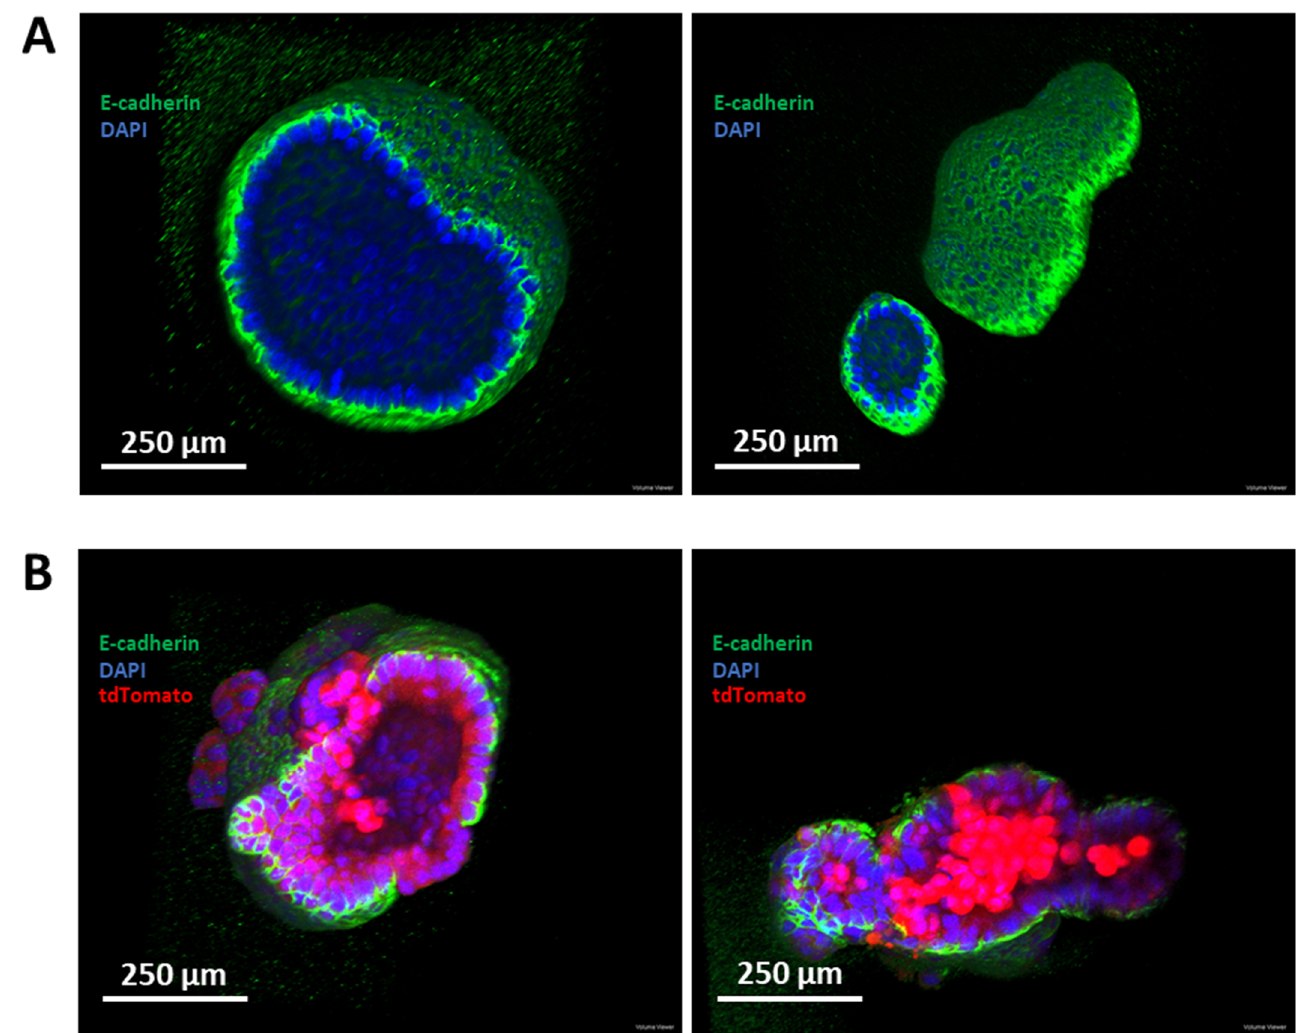
Figure 8. Confocal microscopy of organoids. Immunofluorescence was performed against E-cadherin, with DAPI-stained nuclei. Confocal images represent the focal planes running through the approximate centre of the organoids. ( A ) Highly structured organoids derived from Cdh1 fl/fl mice without induction of Cre recombinase. ( B ) Relatively disorganised organoids derived from Cdh1 fl/fl mice with induction of Cre recombinase. Some organoids maintain a hollow lumen (left), while others contain a dense core of Cdh1 –/– cells.